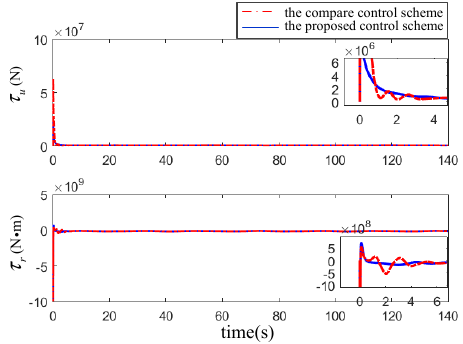
Figure 12. The control inputs τ u and τ r of comparison experiment: the proposed scheme (solid line) and the result in [28] (dot dash line). Table 2. The main comparison results for two algorithms. Indexes Items The Proposed